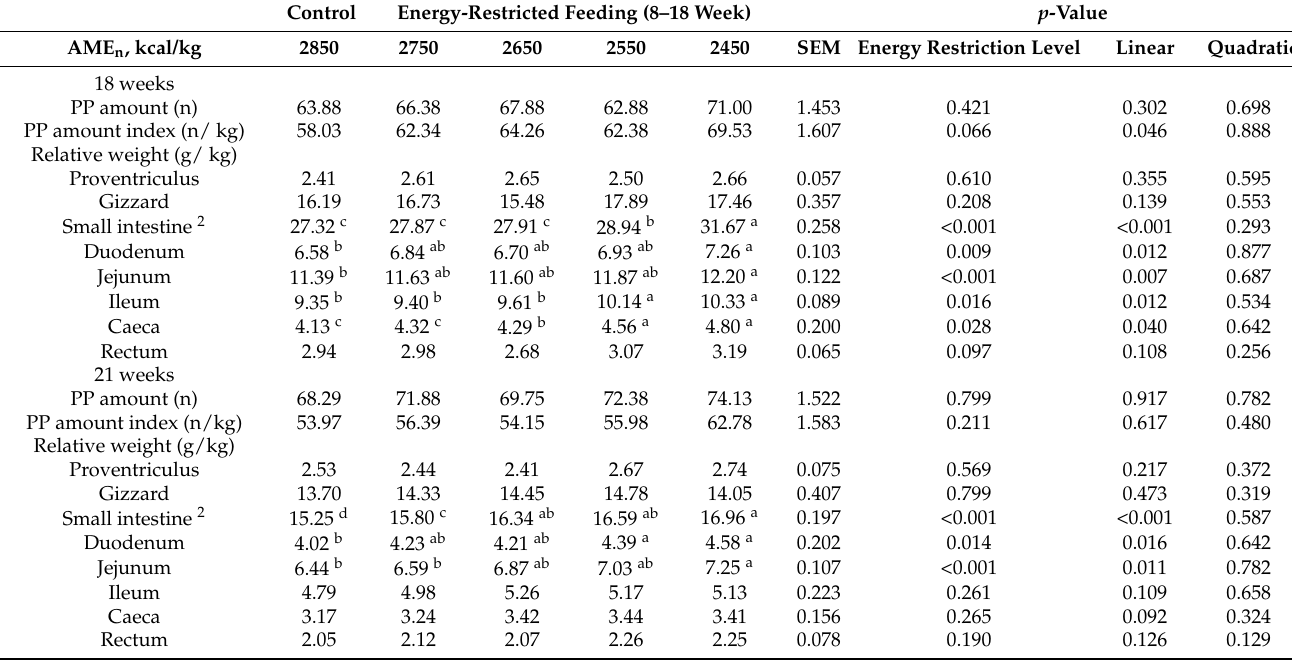
Table 7. Effects of energy-restricted feeding and switching to ad libitum feeding on PP traits and the relative weights of the GIT (g/kg BW) of the pullets at 18 and 21 weeks of age. 1.